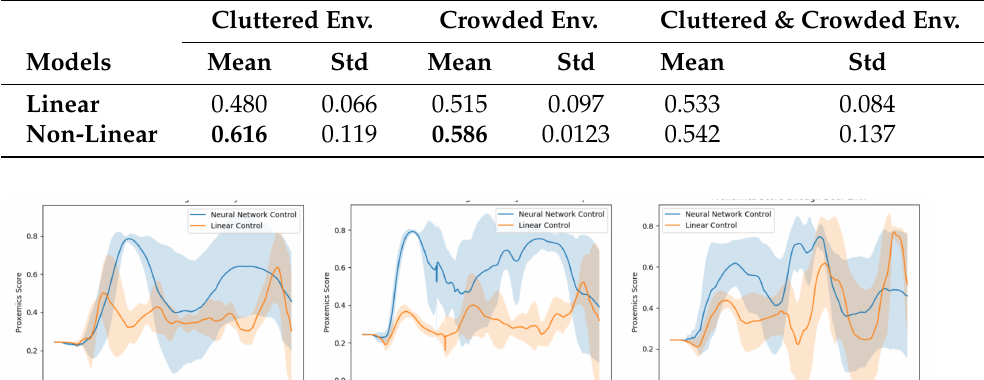
Table 4. Nonlinear model performance against the previous approach, linear model. Evaluation done through the proxemics social distance metric. Bold shows the best value. Cluttered Env. Crowded Env. Cluttered & Crowded Env.